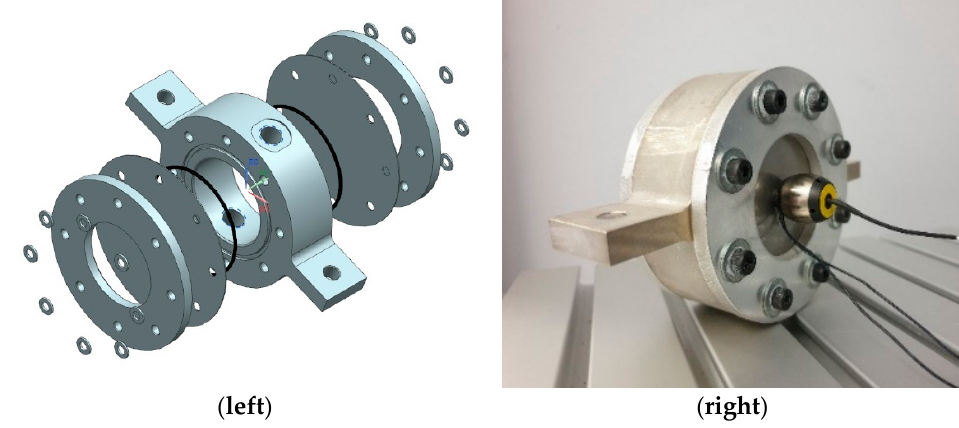
Figure 1. Exploded view of the fixture ( left ) and assembly of the fixture in reality ( right ). The filling of the cylindrical cavity in the base body is made possible via two inflow openings. These inflow openings are positioned radially. These openings are each closed with a screw plug, which is provided with a rubber sealing ring. During assembly, all screw connections are tightened with a defined